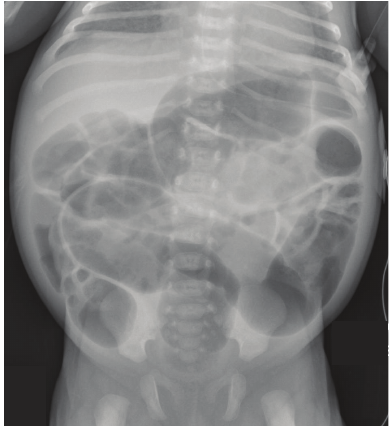
Figure 2: A representative abdominal radiograph obtained on HD 11 revealed gaseous distention consistent with an adynamic ileus withoutevidenceofbowelobstruction.Apaucityofairintherectum is again seen.